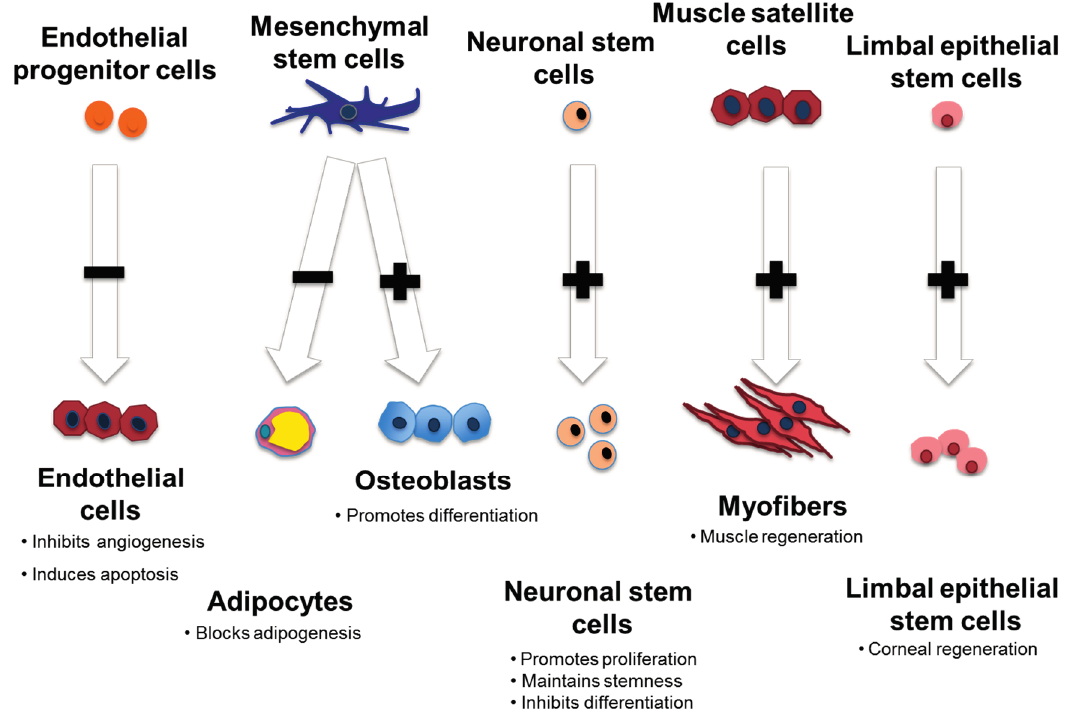
Figure 2. Pigment epithelium-derived factor (PEDF) regulates the proliferation and differentiation of multiple tissue-specific stem cells. PEDF targets proliferating but not resting endothelial cells. PEDF directs mesenchymal stem cells to the osteoblast lineage, while inhibiting adipogenesis. PEDF promotes neurogenesis in neuronal stem cells but causes neuronal differentiation of more committed precursors. PEDF also causes proliferation of muscle progenitors and limbal epithelial cells that are important for corneal